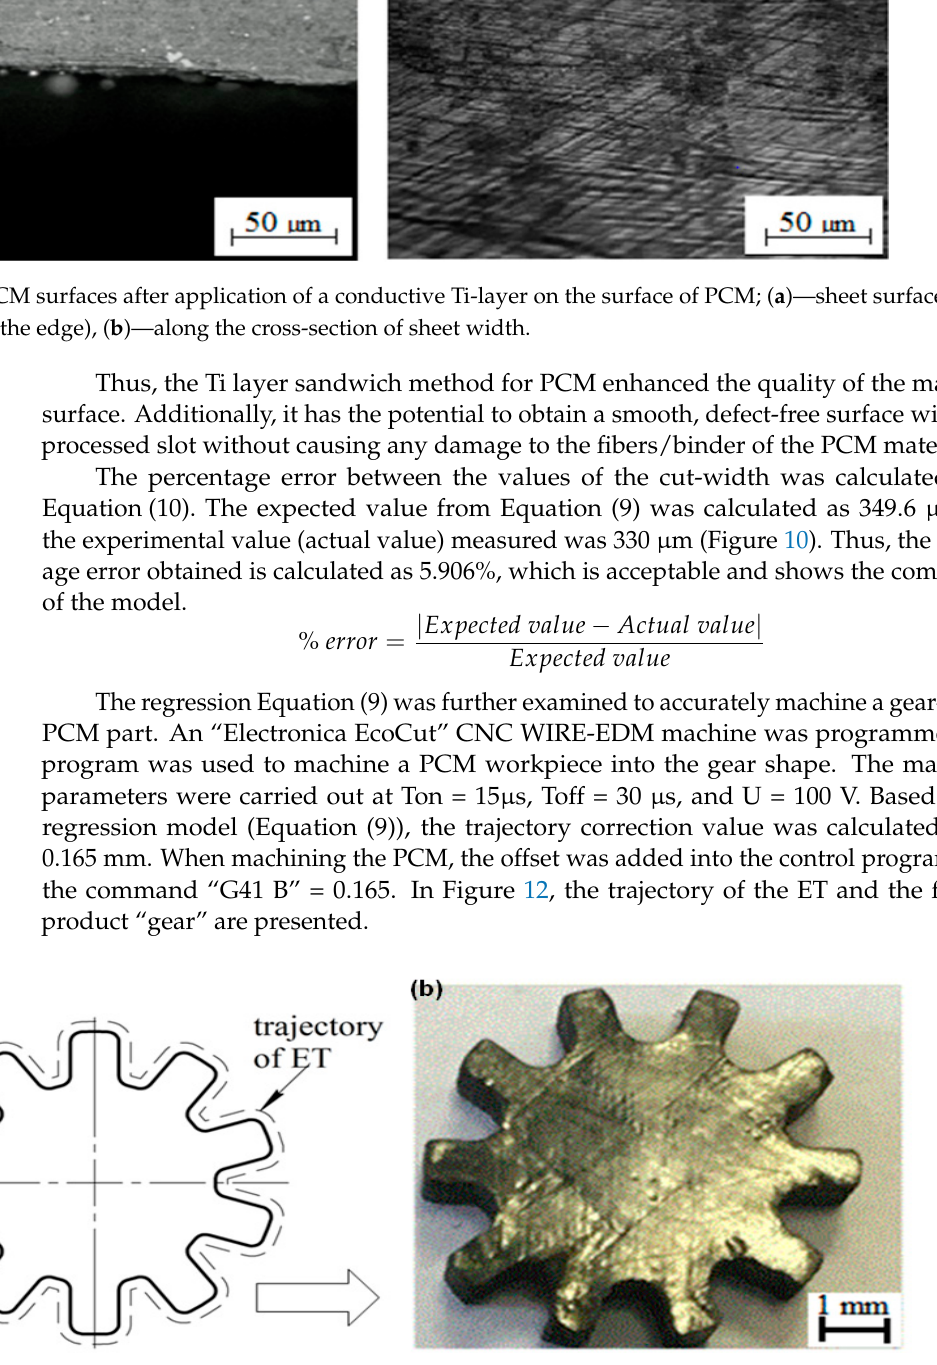
Figure 10. Values of the cut width for PCM wire-cut electro-discharge machining (WIRE-EDM) at U = 100 V, Ton = 15 μ s, Toff = 30 μ s: L 1 = 325 μ m, L 2 = 345 μ m, L 3 = 325 μ m, L 4 = 330 μ m.